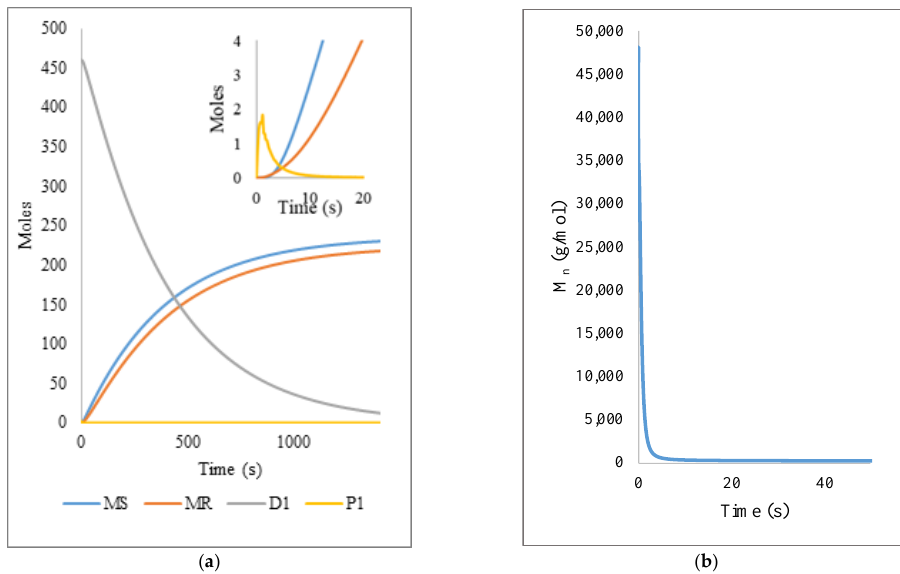
Figure 9. ( a ) Variation of MS (styrene monomer), MR (monomeric radical), D1 (dead polymer), and P1 (living polymer) in the pyrolysis of FRP-PS. ( b ) Time evolution of the number average molecular weight of the polymer in the pyrolysis of FRP-PS. Model predictions at 390 ◦ C and reaction formulation as in Table